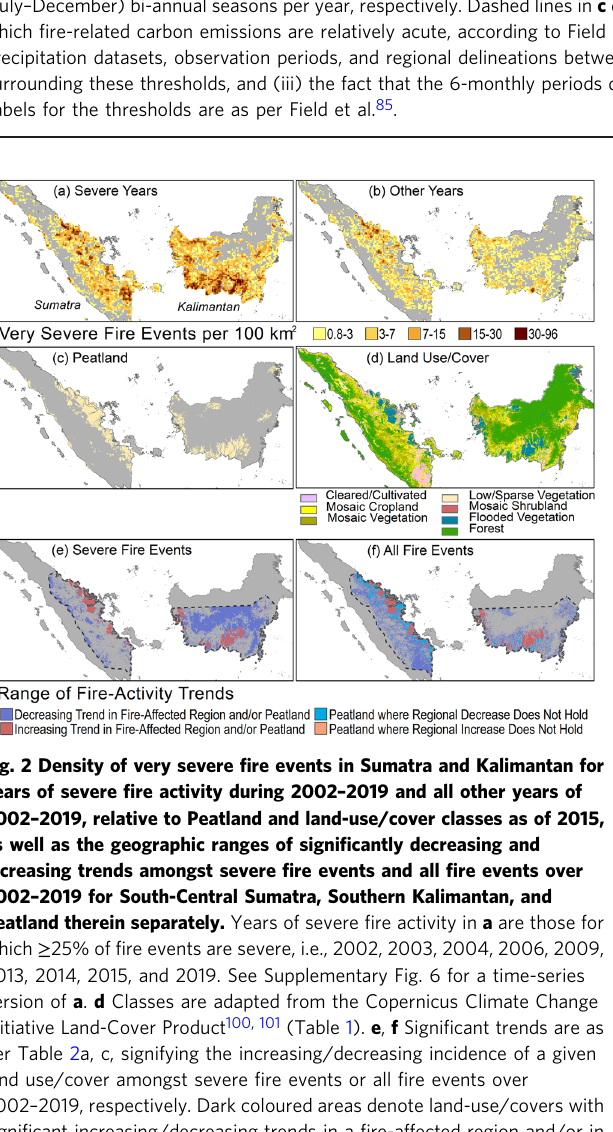
Fig. 1 Declining annual rates of severe and very severe fi re events, Indonesia, controlling for fi re-season precipitation, alongside mean total seasonal precipitation by region. In a and b , years of severe fi re activity are those for which ≥ 25% of fi re events are severe, i.e., 2002, 2003, 2004, 2006, 2009, 2013, 2014, 2015, and 2019. Fire activity is de fi ned as national annual AFD frequencies, being also model weights. The area of annual fi re-activity circles in a , b is proportional to annual AFD frequencies. Trend lines in a , b are as per regressions on total precipitation per fi re season (July – December) and time elapsed since 2002. For visualisation of the effects of time elapsed in a , b , trend lines hold precipitation constant as the July – December mean for 2002 – 2019. Precipitation in c is according to IMERG v06B monthly estimates 88 . X-axis labels ‘ 1 ’ and ‘ 2 ’ denote the fi rst (January – June) and second (July – December) bi-annual seasons per year, respectively. Dashed lines in c describe regional estimates of six-monthly total precipitation thresholds below which fi re-related carbon emissions are relatively acute, according to Field et al. 85 for 1997 – 2006. These are indicative only, given (i) differences in the precipitation datasets, observation periods, and regional delineations between this study and Field et al. 85 , (ii) the sizable 95% con fi dence envelopes surrounding these thresholds, and (iii) the fact that the 6-monthly periods de fi ning these thresholds are not necessarily our bi-annual seasonal intervals. Labels for the thresholds are as per Field et al. 85 .